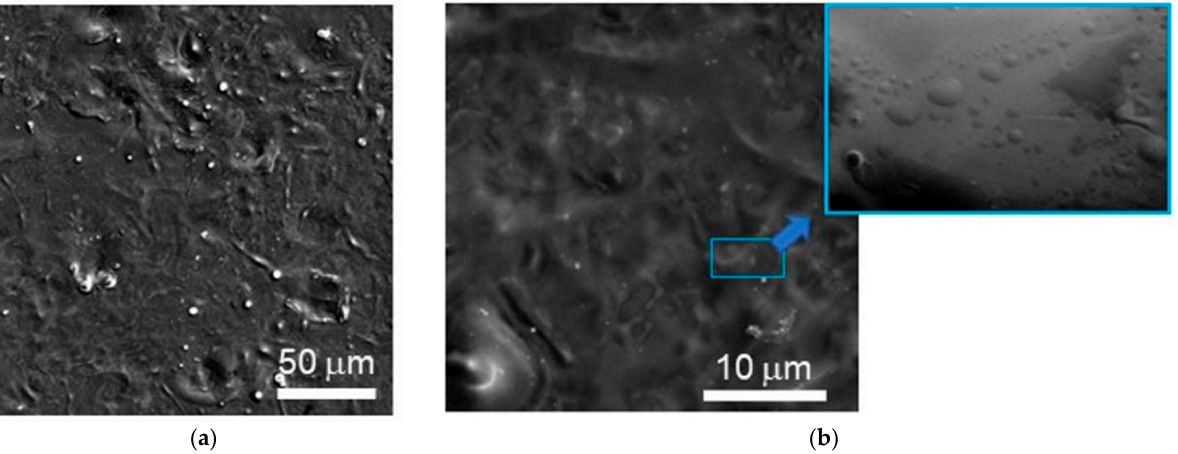
Figure 1. SEM images of the surface of a p-Si wafer after pulsed laser P-doping in an H 3 PO 4 solution measured with ( a ) low and ( b ) higher magnification. The insert in ( b ) shows a periodic surface structure consisting of rounded nano-hills.